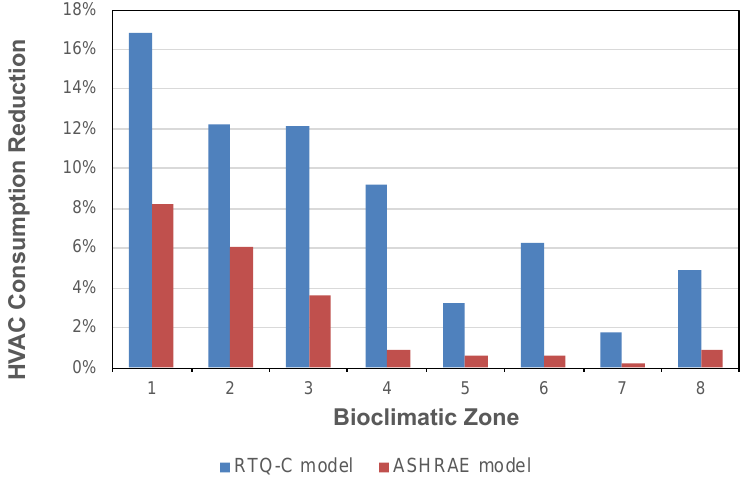
Figure 9. HVAC reduction for T ch /T as integrated optimisation control.